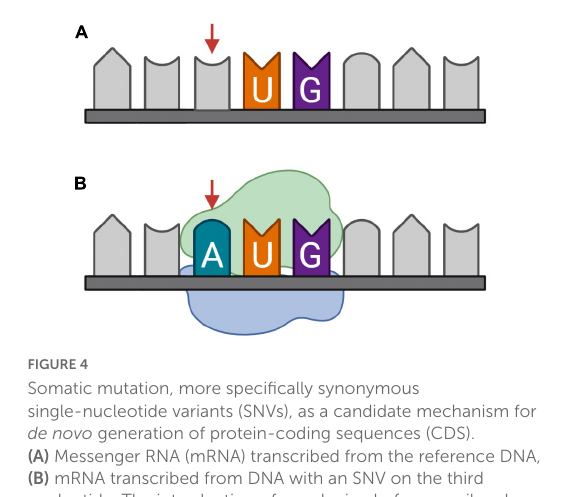
FIGURE4 Somatic mutation, more specifically synonymous single-nucleotide variants (SNVs), as a candidate mechanism for de novo generation of protein-coding sequences (CDS). (A) Messenger RNA (mRNA) transcribed from the reference DNA, (B) mRNA transcribed from DNA with an SNV on the third nucleotide. The introduction of an adenine before uracil and guanine, respectively, forms an AUG codon on which initiation potentially takes